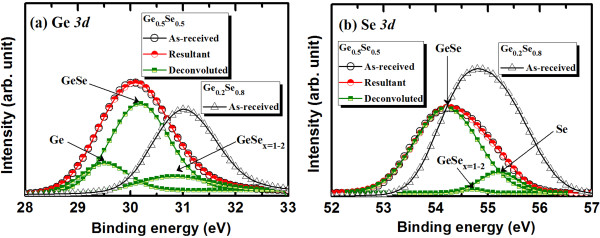
XPS spectra. (a) Ge 3d and (b) Se 3d core-level electrons for Ge0.5Se0.5and Ge0.2Se0.8solid electrolytes.